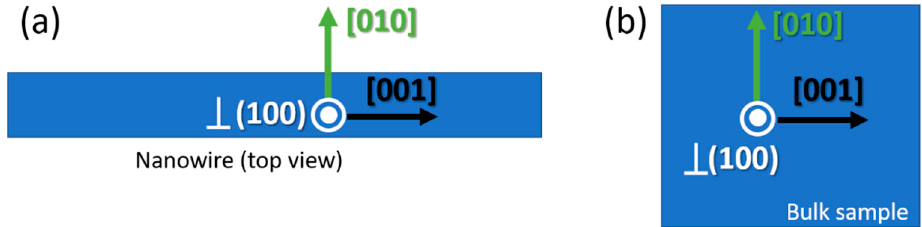
Figure 1. Sketch of the orientations of the crystal and the reference system, for both ( a ) nanowires and ( b ) bulk Ga 2 O 3 crystals. and ( b ) bulk Ga 2 O 3